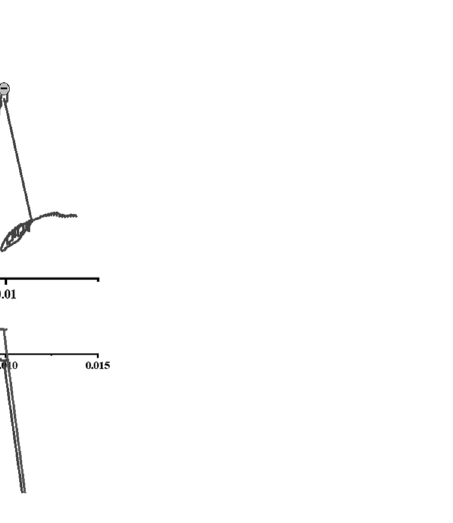
Figure 13. Progressive failure curve when the joint plane is α =